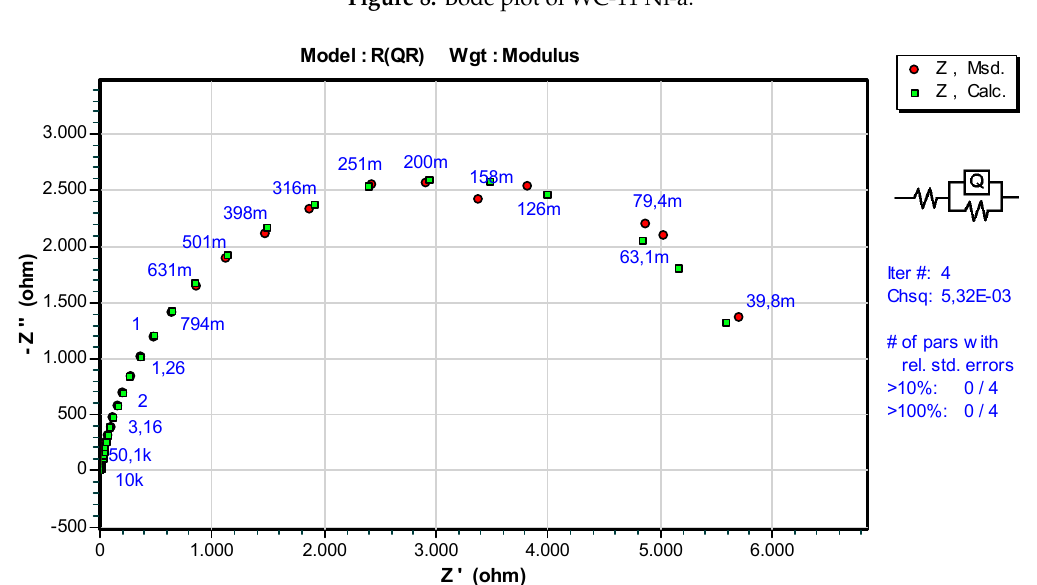
Figure 8. Bode plot of WC-11 Ni-a.